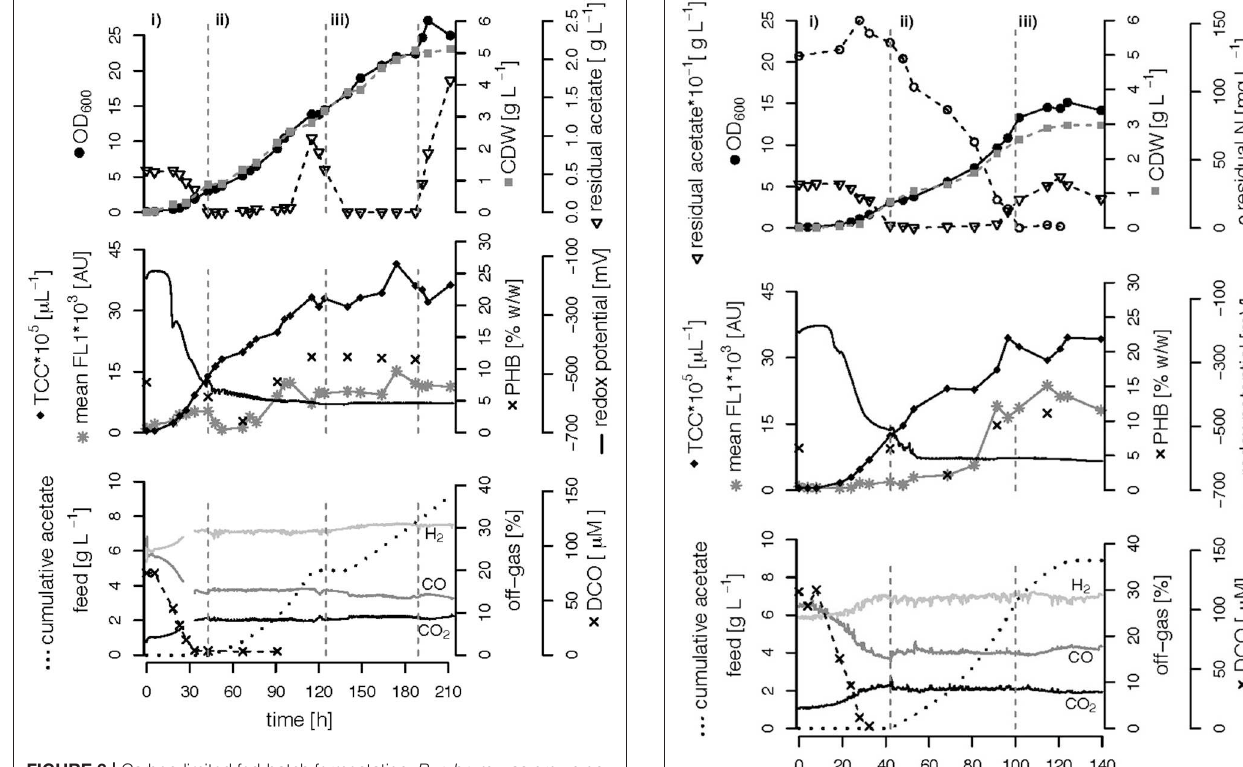
FIGURE 3 | Carbon-limited fed-batch fermentation. R. rubrum was grown on modified RRNCO medium with continuous syngas supply. The different phases of the process are separated by gray, dashed lines: (i) batch phase during which the initial acetate is consumed; (ii) and (iii) acetate fed-batch phase. Please note that the distinction in phases (ii) and (iii) is in this experiment only for ease of clarity and coincides with the phase of a second nutrient limitation in other fed-batches. Concentrations of CO, H 2 , and CO 2 in the off-gas are labeled in the plot. CDW: cell dry weight, TCC: total cell count, mean FL1: fluorescence signal from labeled, intracellular PHB, DCO: dissolved CO.